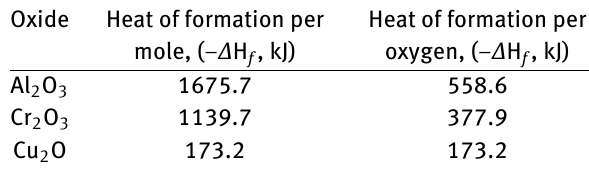
Table 3: Heat of formation ( − ∆ H f ) of oxides per a mole and an oxy- gen in order of decreasing